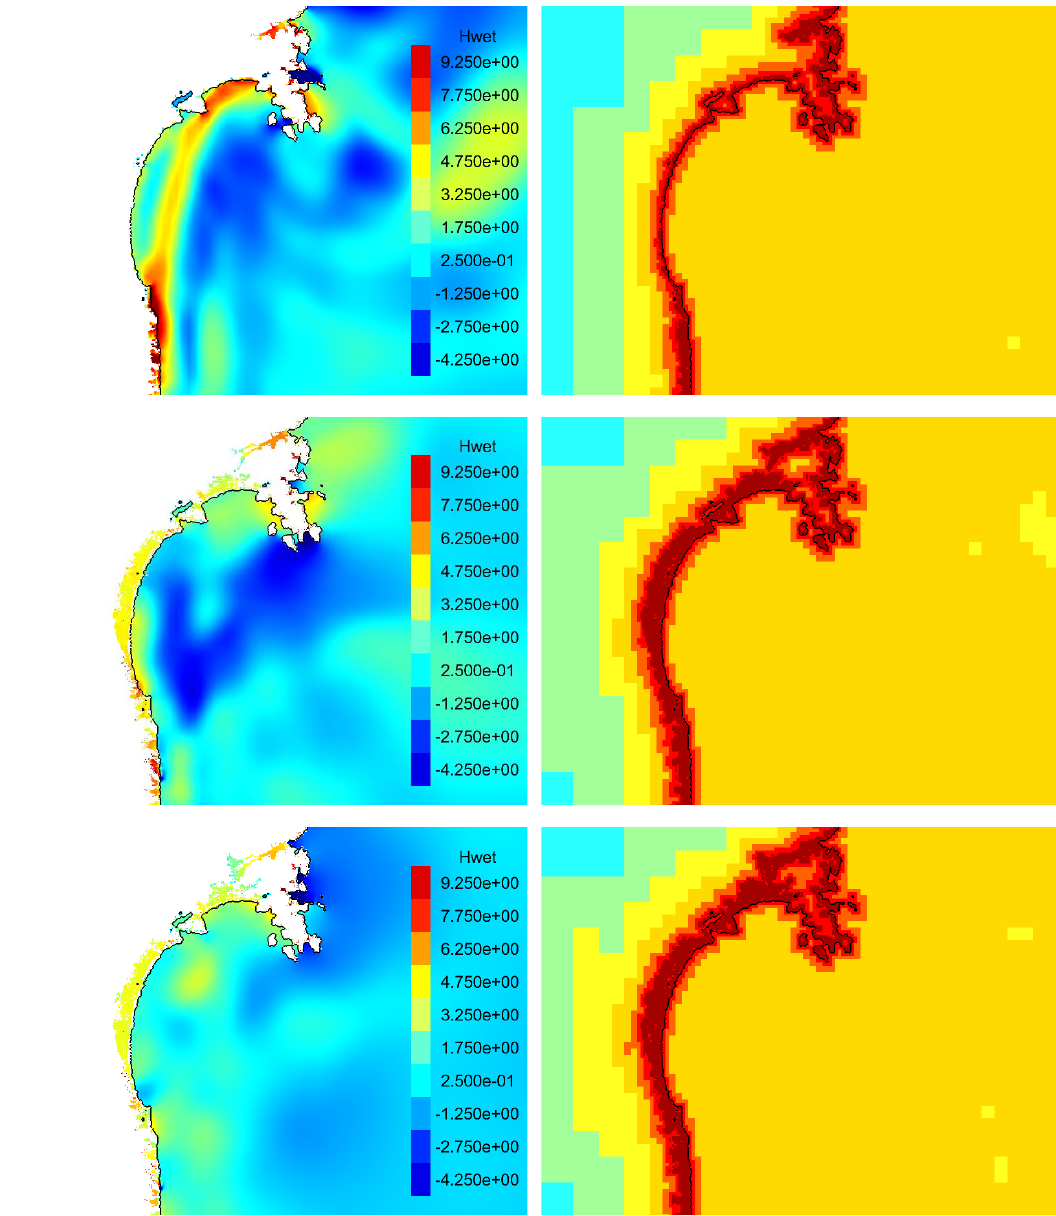
Fig. 7. Detail of the wave evolution in the Miyagi prefecture area. The black line in all figures is the coastline. Rows from top to bottom, t = 1 , 2 , 4h. Left column: evolution of wave elevation (colorbar in metres). Right column: corresponding evolution of spatial resolution, yellow 12 levels ≈ 1arc-min, dark red 15 levels ≈ 8arc-s ≈